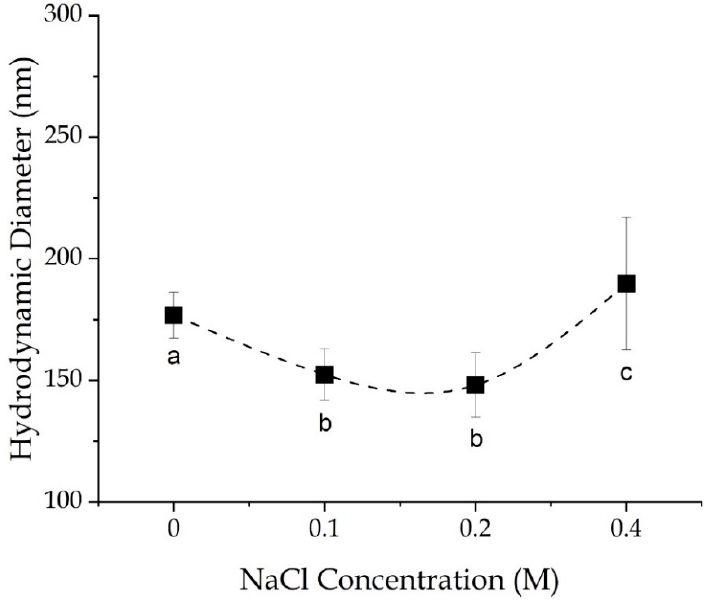
Figure 5. Hydrodynamic diameter (nm) of SPPH at different NaCl concentrations. Different letters in the line show significant difference ( p < 0.05). Dash line is a guide to the eye.